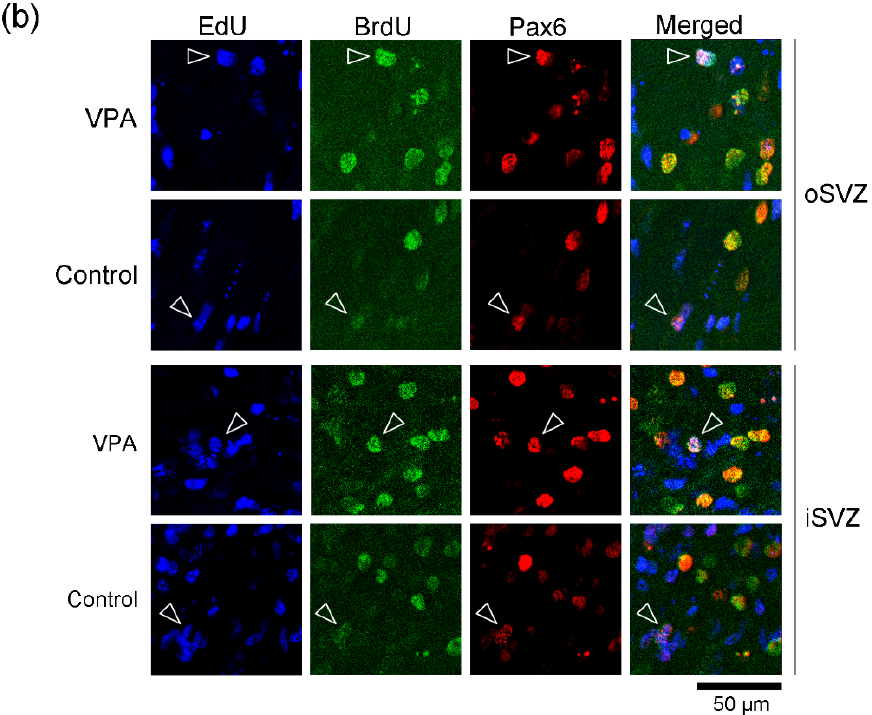
Figure 2. Pax6 immunofluorescence with EdU and BrdU labeling in the SVZ of the premature cortex of VPA-exposed and control ferrets at PD 7. ( a ) Low-magnification images of the oSVZ through iSVZ. ( b ) High-magnification images of the oSVZ and iSVZ. Open arrowheads, Pax6-positive progenitors with EdU/BrdU double labeling.